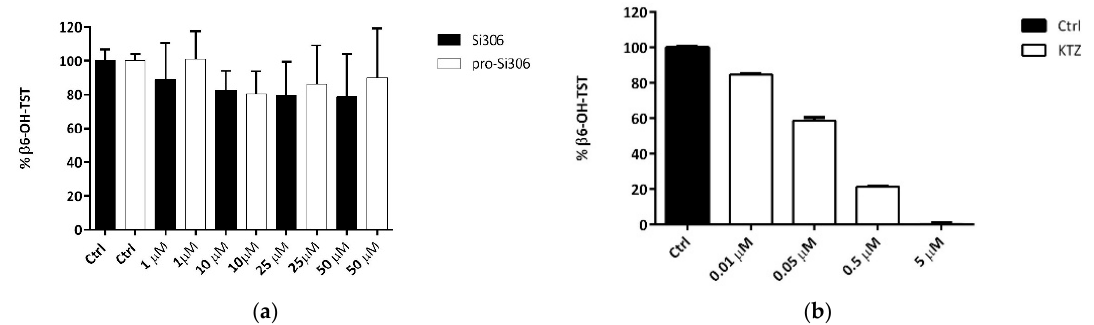
Figure 5. Inhibition of CYP3A4 isoform activity by Si306 and pro-Si306 ( a ) and ketoconazole (KTZ, b ), measured as % β 6-hydroxytestosterone ( β 6-OH-TST) mean ± S.D., compared to the control (Ctrl) mix in absence of compounds ( n = 3).